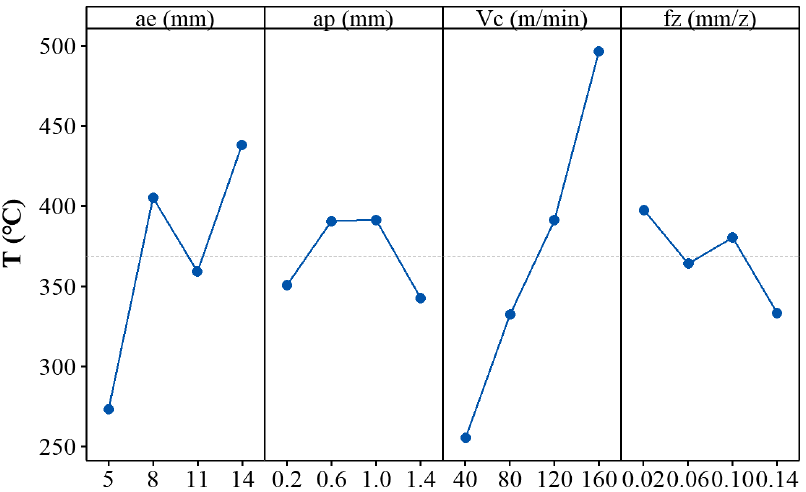
Figure 7. Plot of means for the maximum cutting temperature T .